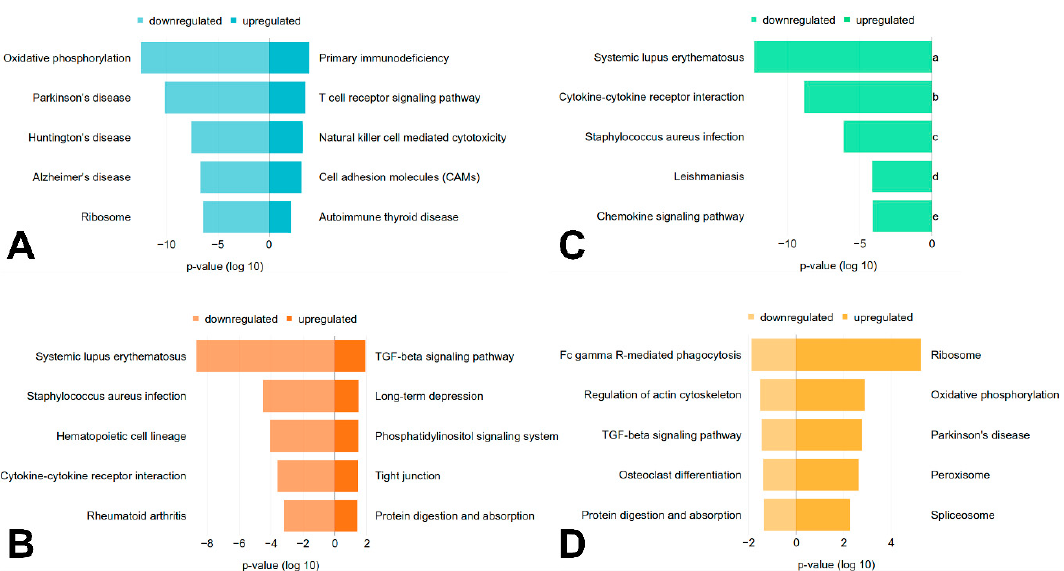
Figure 2. Regulated pathways. The top five significantly ( p < 0.05, parametric two-sample t -test) up- and downregulated pathways for each genotype ( A ) LMNA , ( B ) RBM20 , ( C ) TTN , ( D ) PKP2